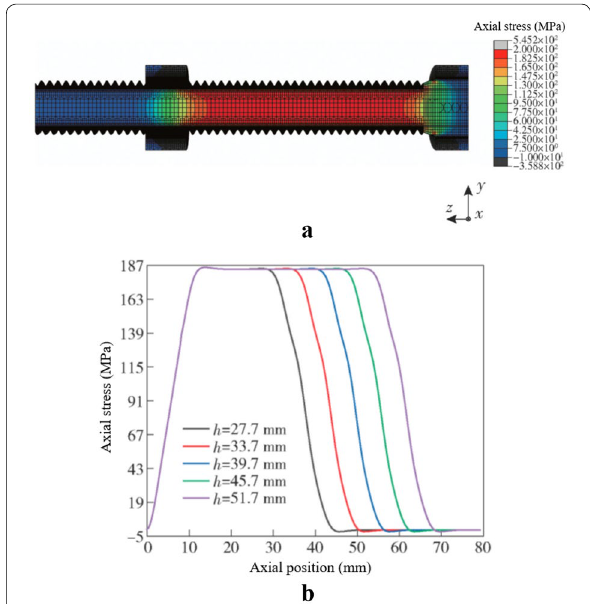
Figure 15 Distribution of stress in a bolted connection [54]: